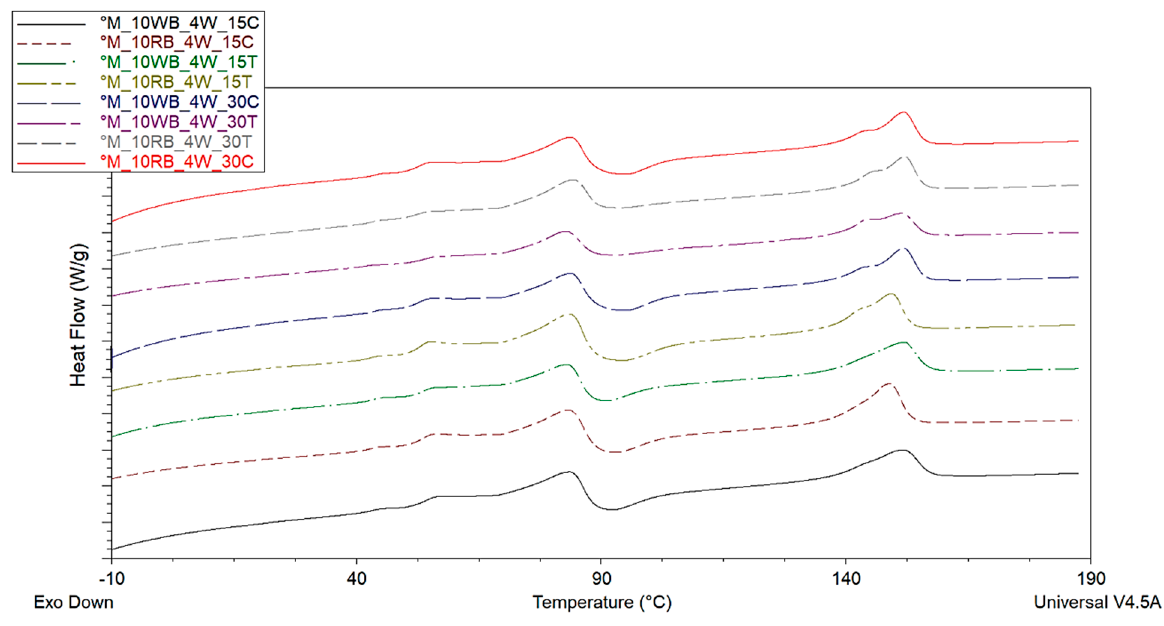
Figure 8. DSC analysis of mineral reinforced biocomposites.